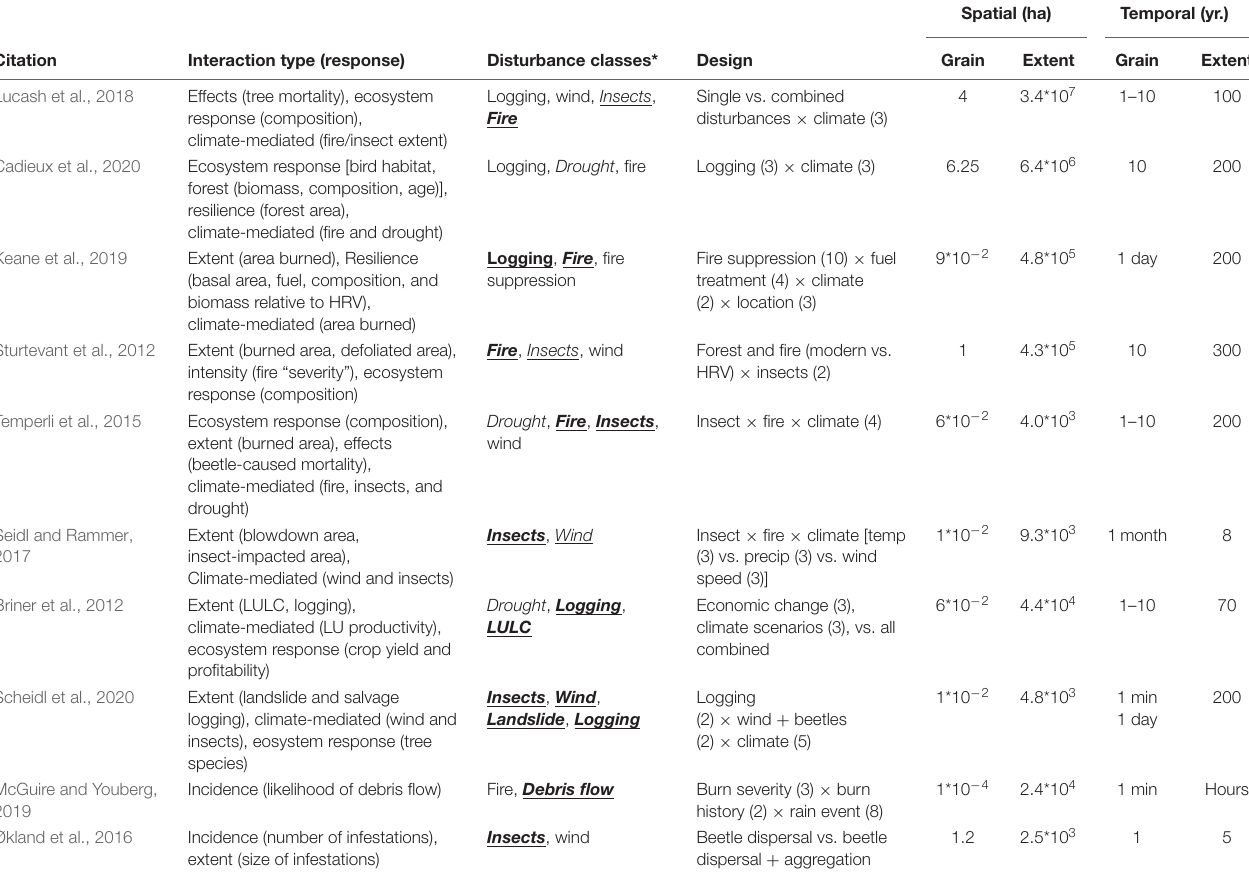
TABLE 6 | Representative studies reviewed in the “Modeling Approaches” Section, including disturbance interaction type(s), response variable(s), disturbance classes, characterization of disturbance components*, study design, and